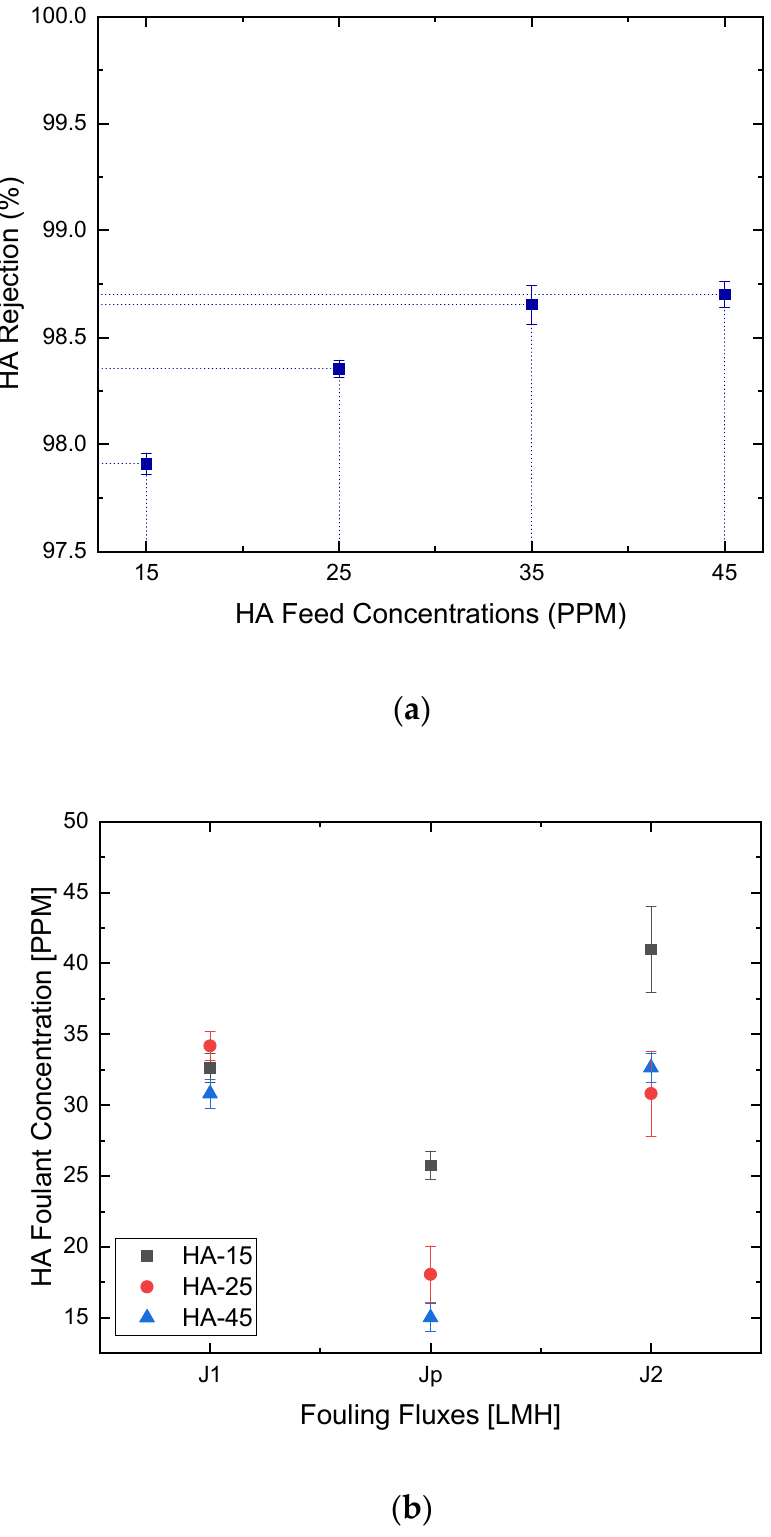
Figure 9. ( a ) HA rejection rates at different HA feed concentrations and ( b ) calculated fouling fluxes at optimum HA foulant concentrations.